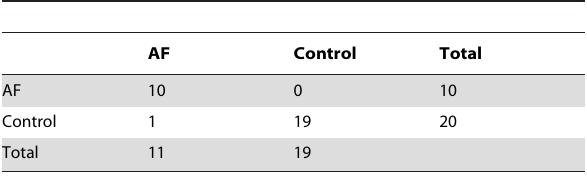
Table 5. Classification of patients combining FL2A, FL2B, FL3A and FL5B by LDA.